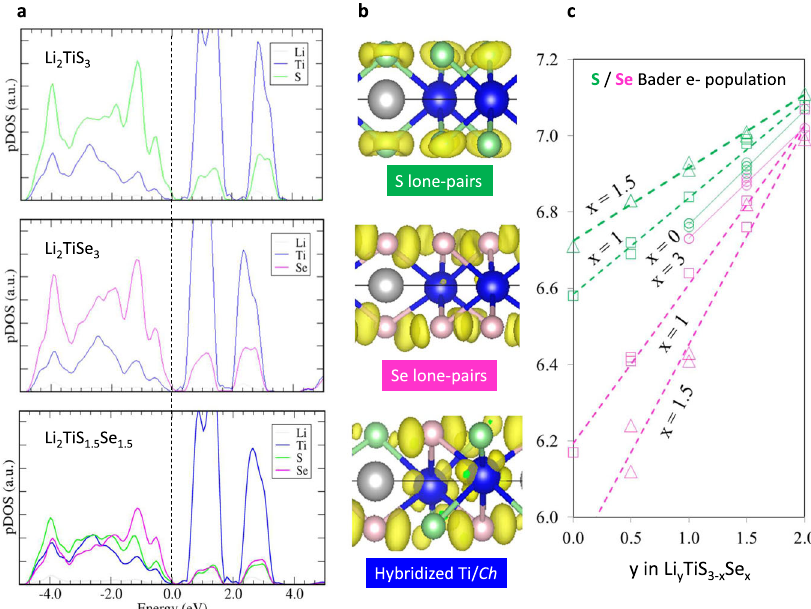
Fig. 7 Theoretical calculations on Li y TiS 3 − x Se x . a Projected density of states (pDOS) of Li 2 TiS 3 , Li 2 TiSe 3 , and Li 2 TiS 1.5 Se 1.5 . b Fukui functions computed to probe the electronic states involved in the oxidation process for the Li 2 TiS 3 , Li 2 TiSe 3 , and mixed Li 2 TiS 1.5 Se 1.5 electrodes: these results clearly show that the holes generated upon oxidation (yellow volume) are mainly localized on the Ch (S and Se) anions for the pure-S and pure-Se electrodes, while the transition metal (Ti) is also involved for the mixed S/Se phases. Note that the Se selectivity in the mixed S/Se electrode is also clearly seen with a larger hole density around Se (pink atoms) much larger than around S (green atoms), therefore highlighting the Se selectivity in the mixed phases. c Atomic Bader net populations of the most oxidized S and Se atoms in the structure as a function of the Li content showing that Se is much more oxidized and S is much less oxidized in mixed S/Se compared to pure-S and pure-Se phases for an equivalent number of extracted lithium. All calculations were performed with the metaGGA SCAN functional (see “ Methods ”